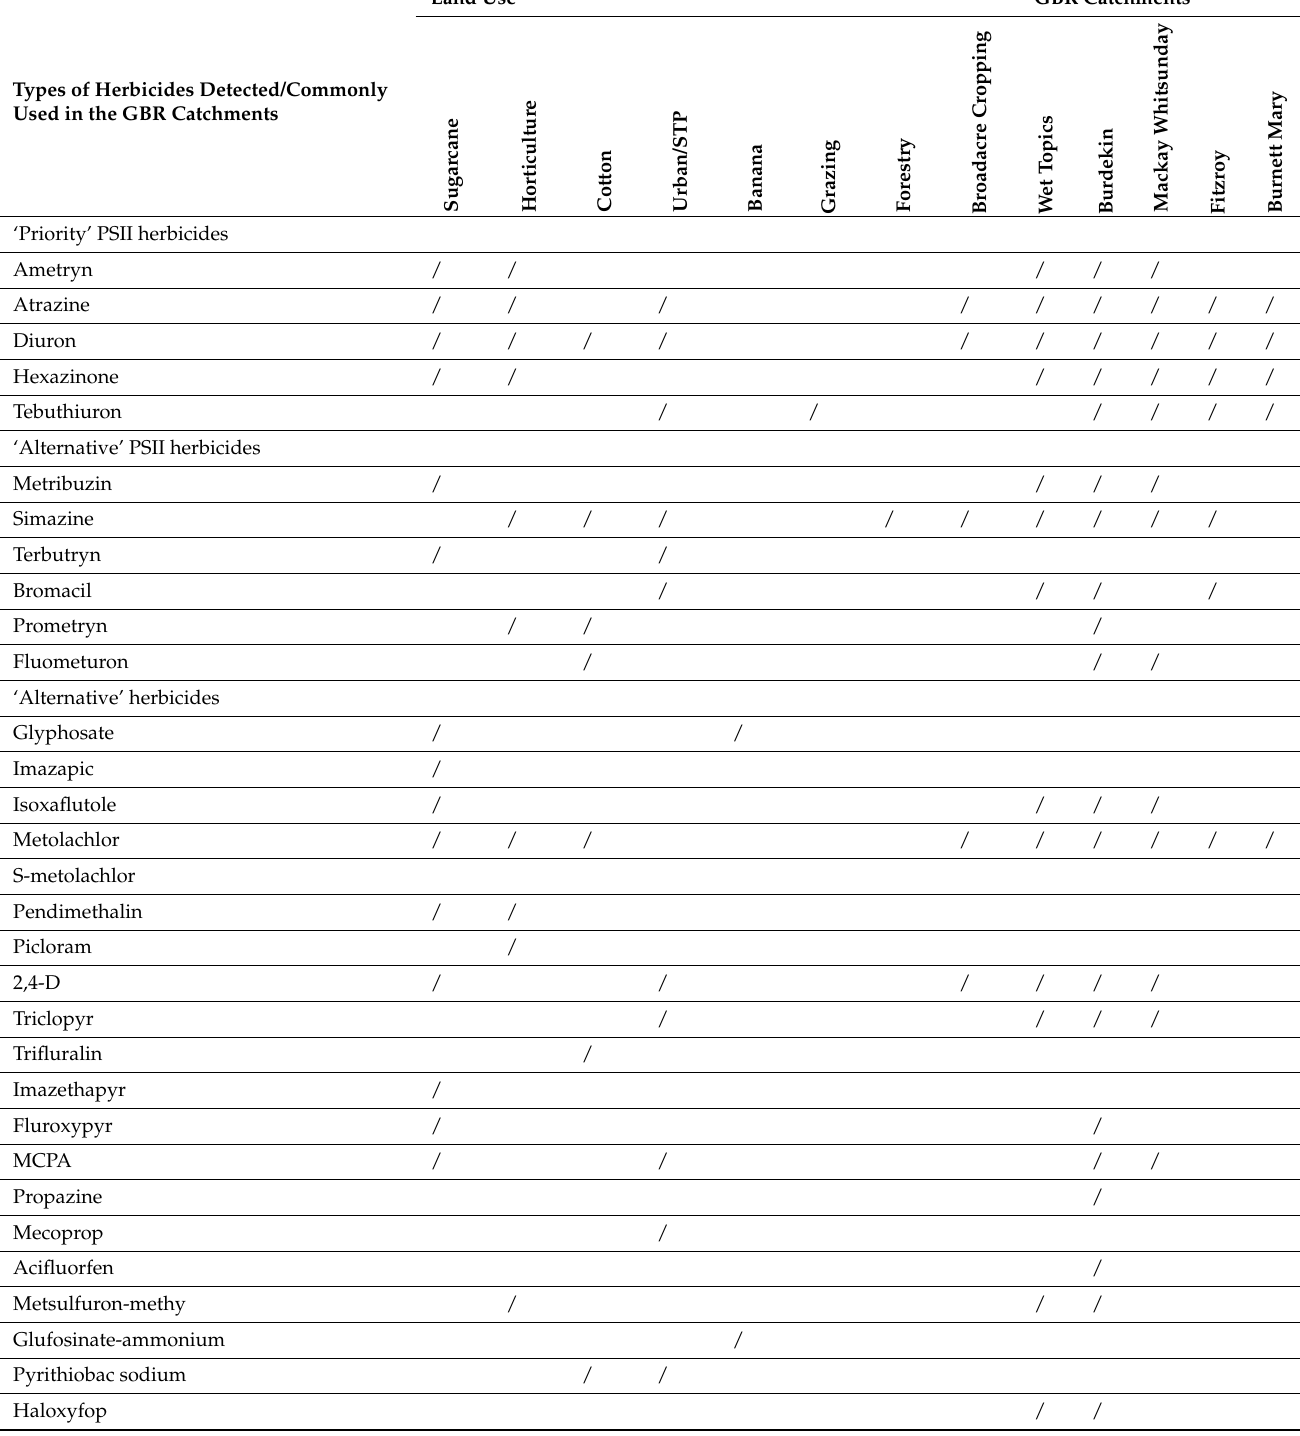
Table 3. List of herbicides detected and commonly used in the GBR catchments